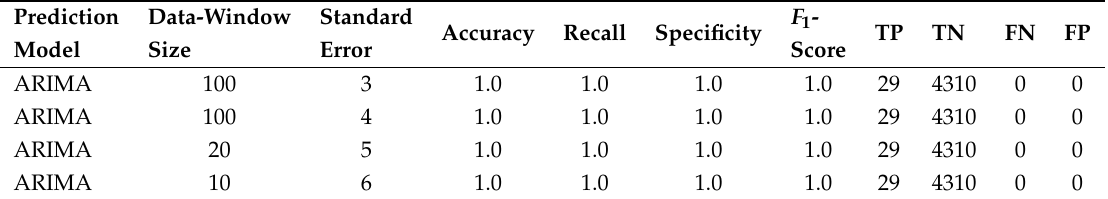
Table 1. Ranking with the first four positions of the results in Exp1, ordered by F 1 -Score. Prediction